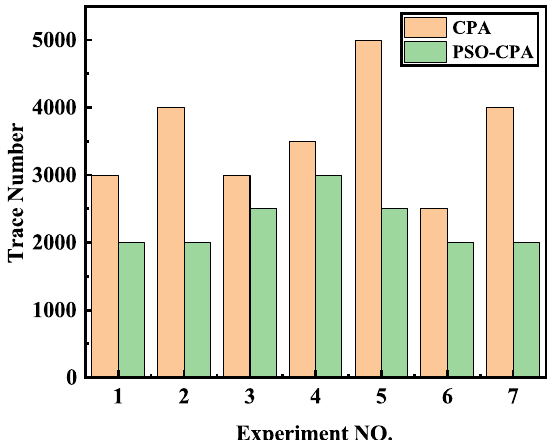
Figure 13. The minimum number of power traces when the right key is